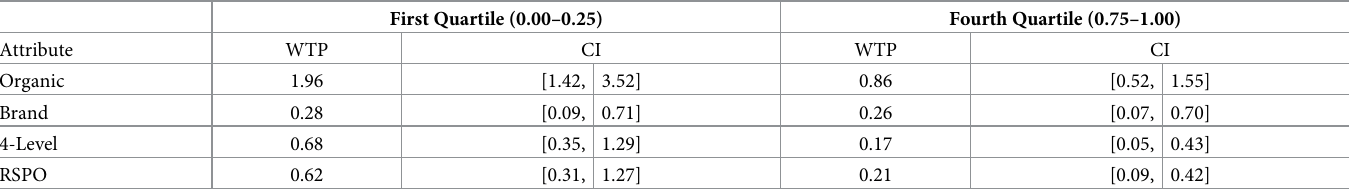
Table 8. Willingness-to-pay estimates first and fourth quartile of predicted LV, no information